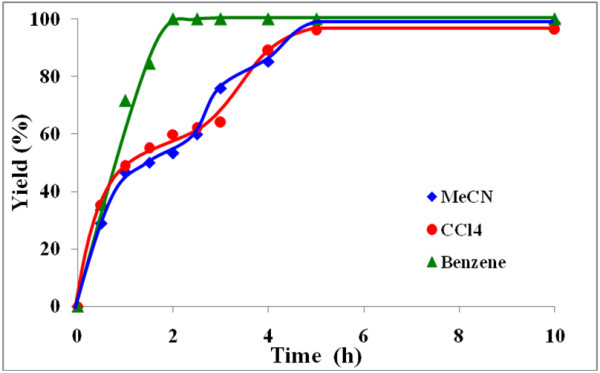
Effect of solvent on % yield of benzil using VOL4 at 50°C.